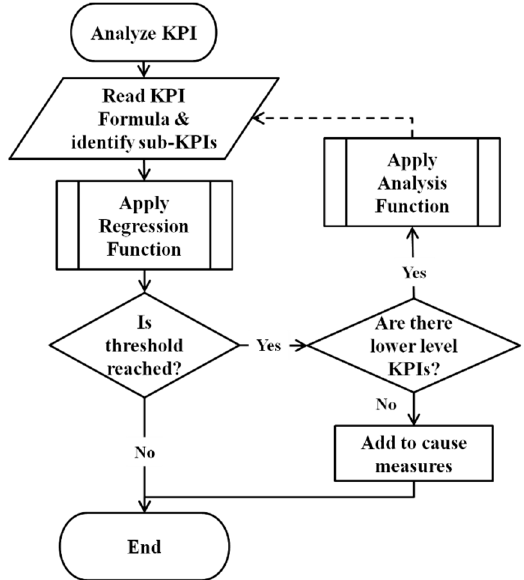
Figure 4. Flow chart of the algorithmic procedure.